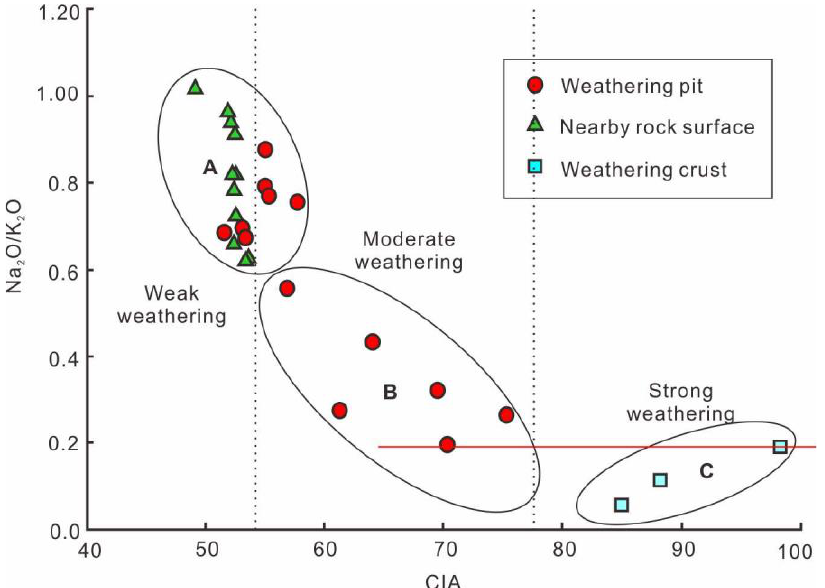
Figure 3. A scatter diagram of CIA vs. Na 2 O/K 2 O shows the weathering intensity that has a trend increasing from the surrounding rock face to the debris in the weathering pit and to the local weathered crust. Three different groups of weathering intensities are classified by CIA values (vertical dotted lines) and by the Na 2 O/K 2 O ratio (ellipses).